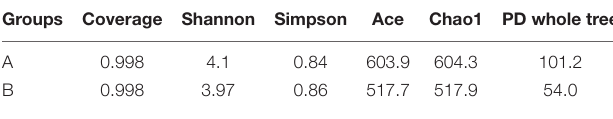
TABLE 2 | α -Diversity indexes of the two study